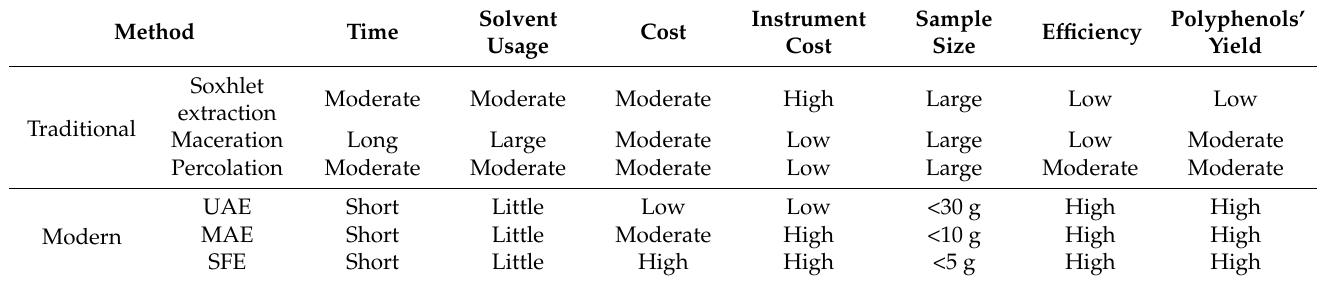
Table 1. Comparison of traditional and modern extraction